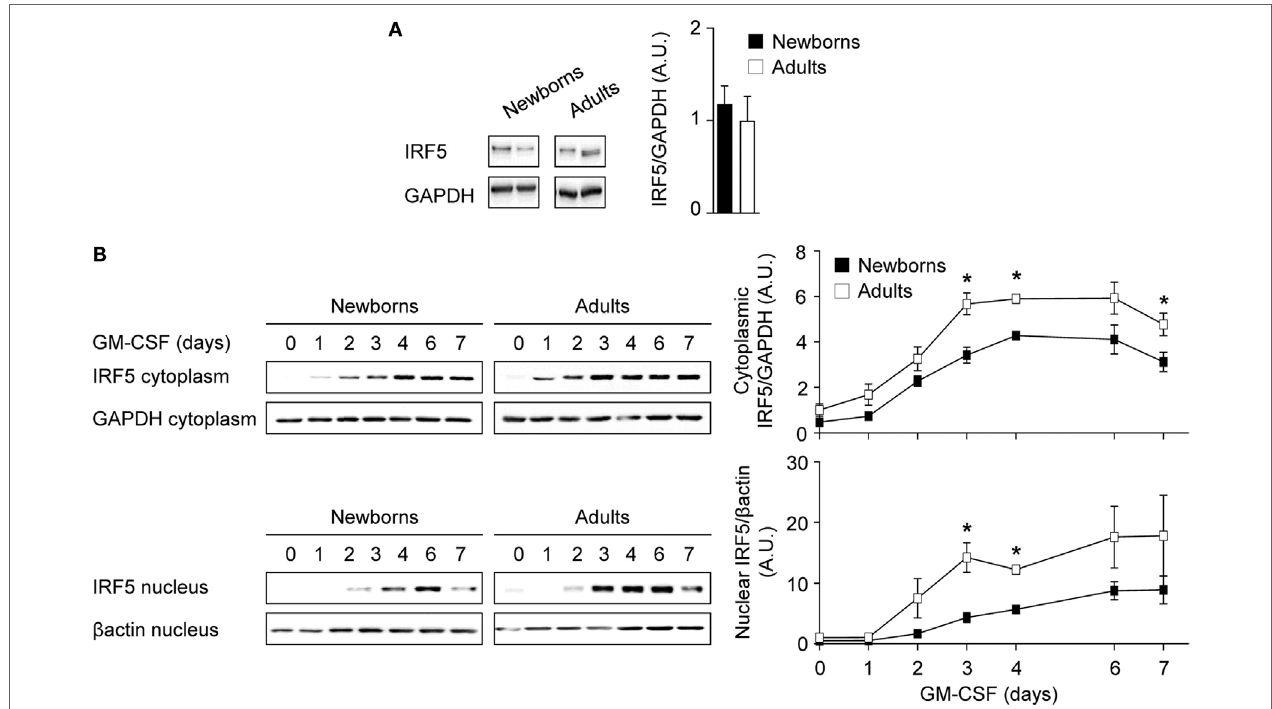
FigUre 4 | Reduced cytoplasmic and nuclear IRF5 levels during GM-CSF-induced monocyte to macrophage differentiation in newborns. (a) Intracellular IRF5 levels in freshly isolated newborn (black bars) and adult (white bars) monocytes. Data are means ± SEM from 10 newborns and 10 adults. (B) Cytoplasmic and nuclear IRF5 levels in newborn (black) and adults (white) monocytes cultured for 0–7 days with 50 ng/ml GM-CSF. IRF5 levels were analyzed by Western blotting (left panels) and quantified by imaging (right panels). Data are means ± SEM from nine newborns and nine adults. * P <